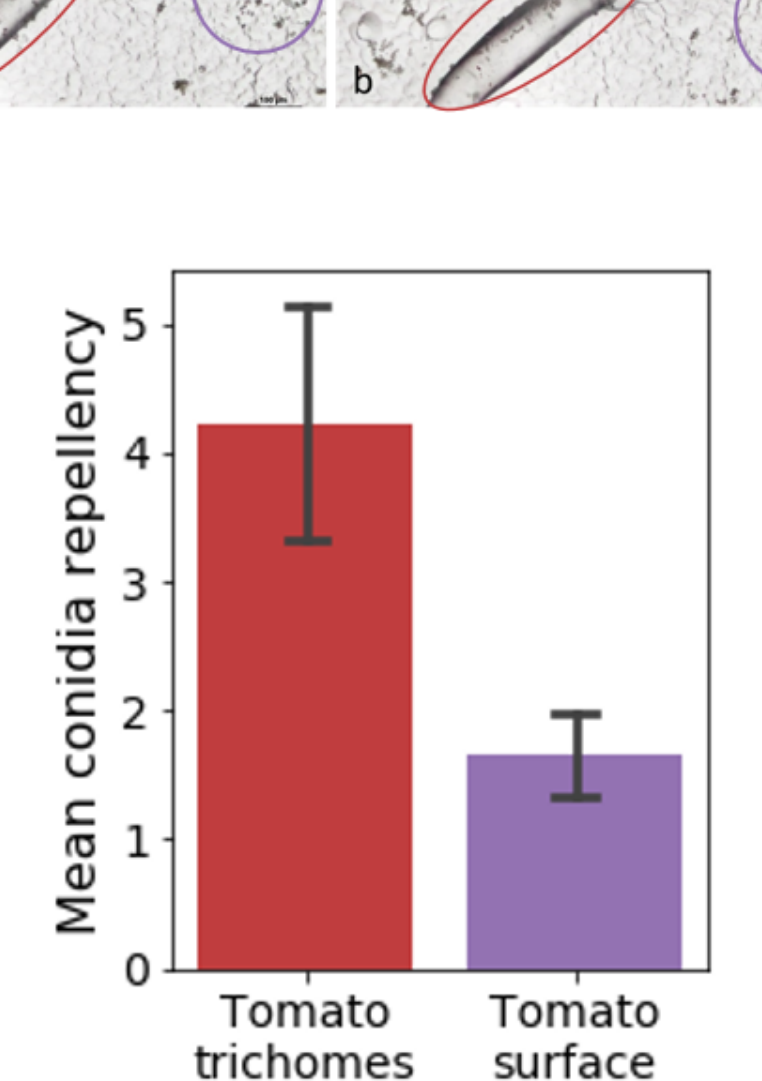
Figure 6. Spore repellency of tomato trichomes replica. ( A ) Microscope images of a trichome and surrounding surface of a tomato leaf replica before ( a ) and after ( b ) wash. The amount of conidia washed from the trichomes (red circles) seems larger than that washed from other parts of the surface (purple circles). ( B ) Quantification of conidia repellency from trichomes (red) and the rest of the surface (purple) replica. Conidia repellency is significantly higher in trichomes than in the rest of the replica surface.